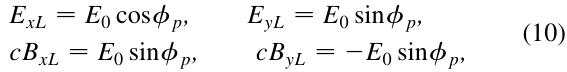
axis. L and " xe ye